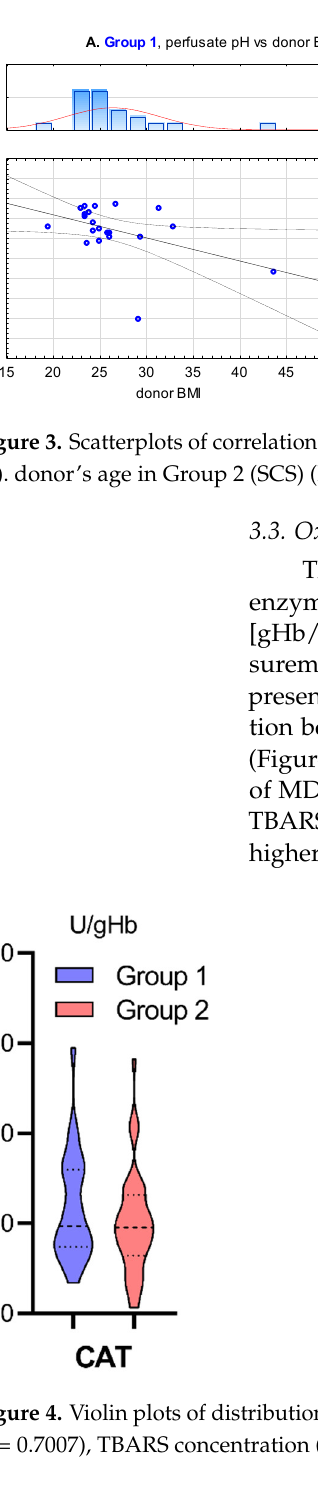
Figure 4. Violin plots of distribution (Mann-Whitney U test, N = 66, n 1 = 26, n 2 = 40): CAT activity ( p = 0.3713), SOD activity ( p = 0.7007), TBARS concentration ( p = 0.6158), MDA concentration (* p = 0.0004 ).